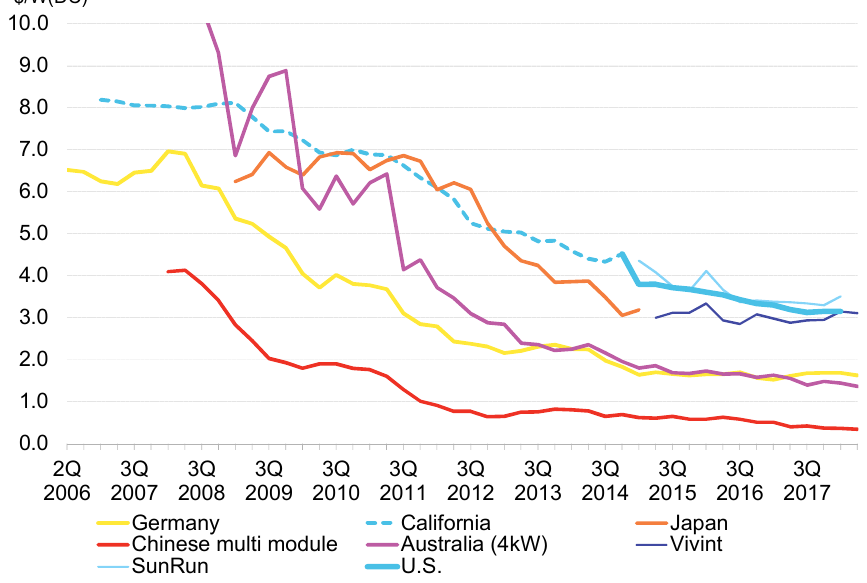
Figure 8. Residential PV system costs in different markets.